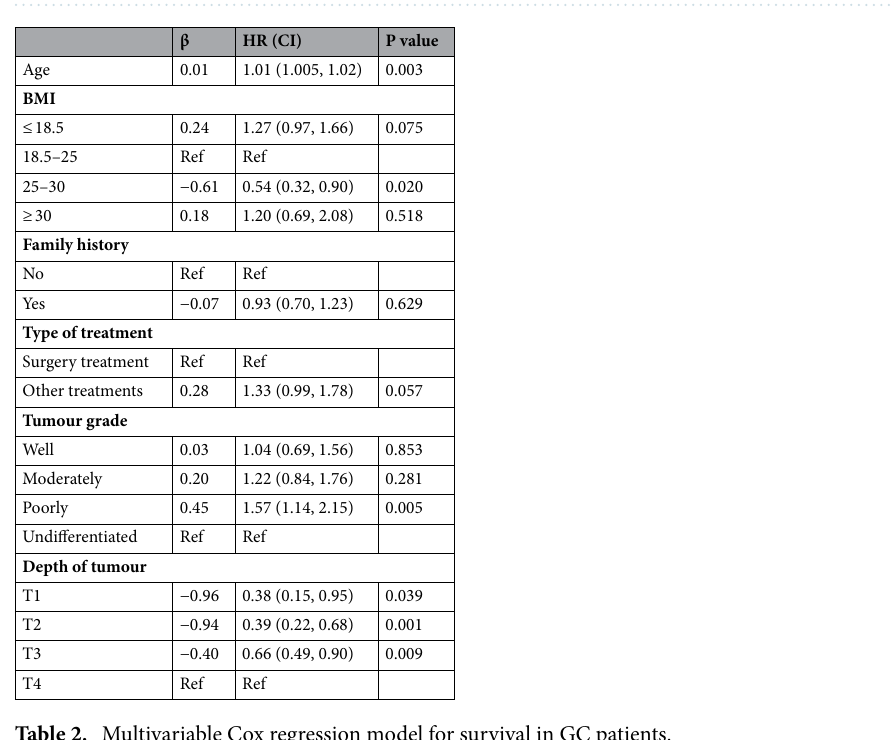
Figure 1. Kaplan–Meier survival curves by American joint committee on cancer staging, along with the number at risks in gastric cancer patients.